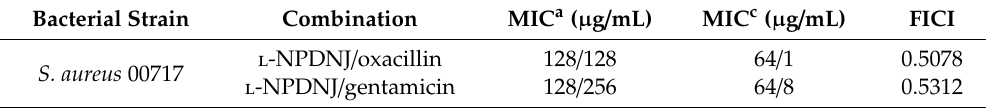
Table 2. Additive effect of L ‐ NPDNJ with antibiotics against S. aureus isolate 00717. Table 2. Additive e ff ect of l -NPDNJ with antibiotics against S. aureus isolate 00717. Bacterial strain Combination MIC a (  g/mL) MIC c (  g/mL) FICI Bacterial Strain Combination MIC a ( µ g / mL) MIC c ( µ g / mL) FICI L ‐ NPDNJ /oxacillin 128/128 64/1 0.5078 S. aureus 00717 l -NPDNJ / oxacillin 128 / 128 64 / 1 0.5078 L ‐ NPDNJ /gentamicin 128/256 64/8 0.5312 S. aureus 00717 l -NPDNJ / gentamicin 128 / 256 64 / 8 0.5312 MIC a , MIC of one sample alone; MIC c , MIC of samples in combination; FICI, fractional inhibitory concentration index. MIC a ,MICofonesamplealone; MIC c ,MICofsamplesincombination; FICI,fractionalinhibitoryconcentrationindex.